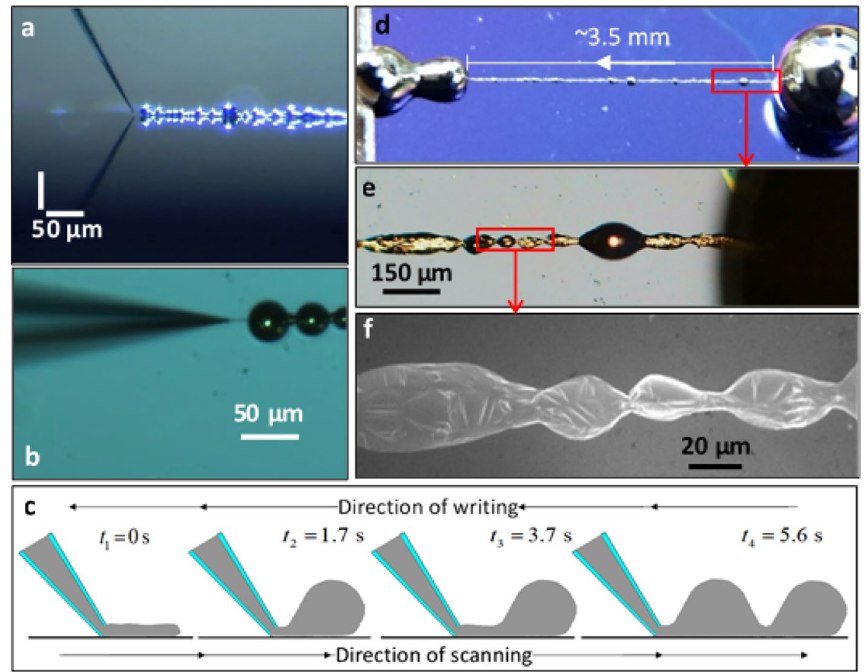
Figure 4. EGaIn on SiO 2 . ( a , b ) Optical images (side and top view, respectively) of the process of extrusion (under constant pressure, ~ 45 atm) of EGaIn on a hydroxilated silicon surface. Microdroplets of the EGaln are apparent. ( c ) A schematic illustration of the process (left to right): after a short segment of the line is released onto the surface, typically 15–20 µm long and 1–3 µm wide, the line quickly congeals (after 1.7–1.9 s) into a microdroplet. As the substrate is being moved in the opposite direction, the metal is continuously extruded, a second line is formed, and then again congeals. In this way, a series of joined microdroplets is formed on the surface. See Supplementary Information S2 for a movie of this dynamic deposition. ( d ) Optical image of the completed pattern, extending for over 3.5 mm. ( e ) Optical image of the marked region in ( d ), showing the area near the initial release (right). ( f ) Electron micrograph of the marked region in ( e ), demonstrating in higher resolution the local structure. The droplets are deformed ellipsoids of varying lengths and widths. The initial stage of the line formation is shown in detail in the Supplementary Information, Fig.